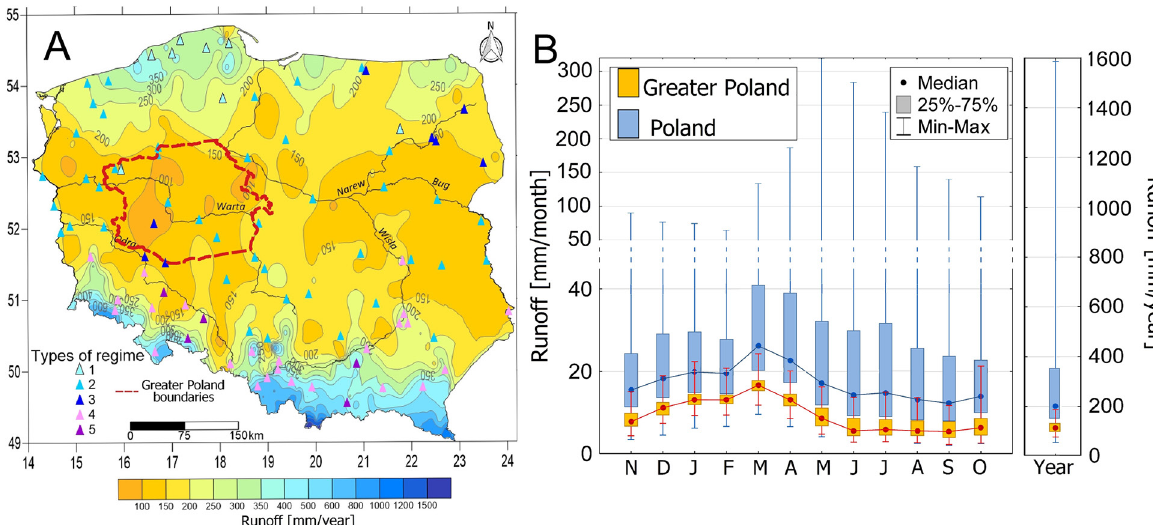
Fig. 12. River runoff and types of the river regime in Poland (A) (types of regimes: 1 – nival poorly formed; 2 – nival moderately formed; 3 – nival well-formed; 4 – nival-pluvial; 5 – pluvial-nival [after Wrzesiński 2021]), and the scope of changes in monthly and annual runoff of rivers in the Greater Poland region and Poland in 1971–2015 (B) (after Wrzesiński and Perz 2019a,